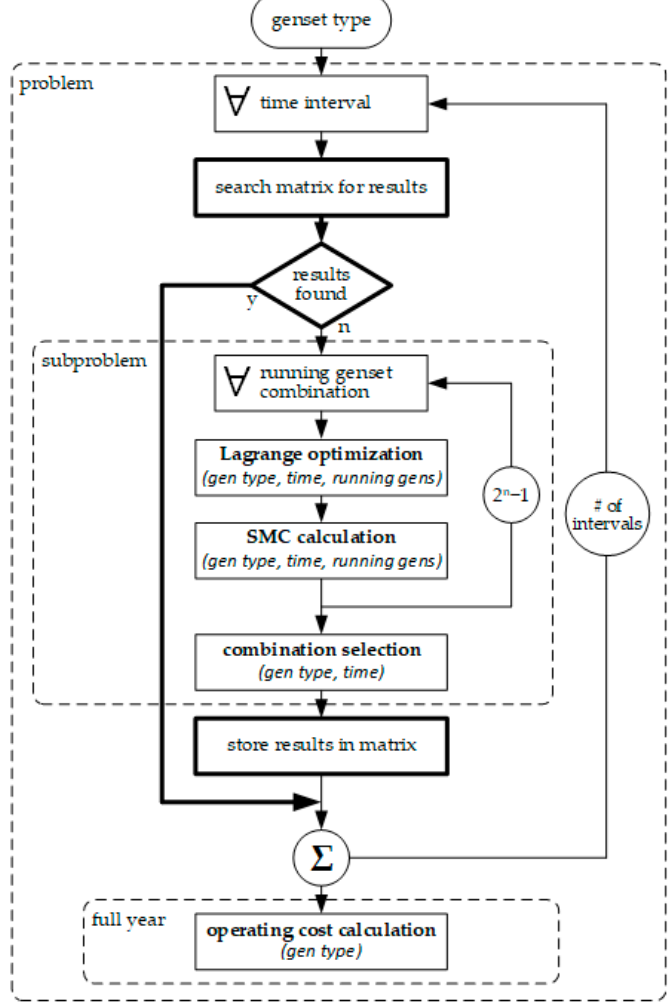
Figure 5. Speed improvement modification.